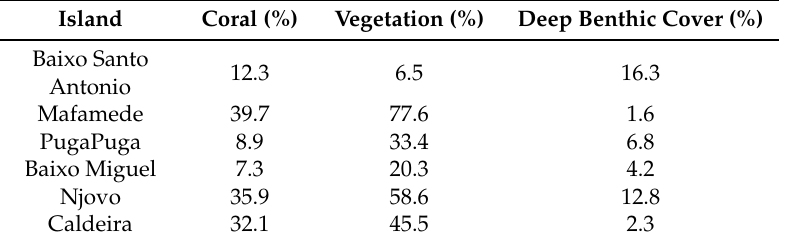
Table 7. Edge similarity index values for results for selected pairs of classes.